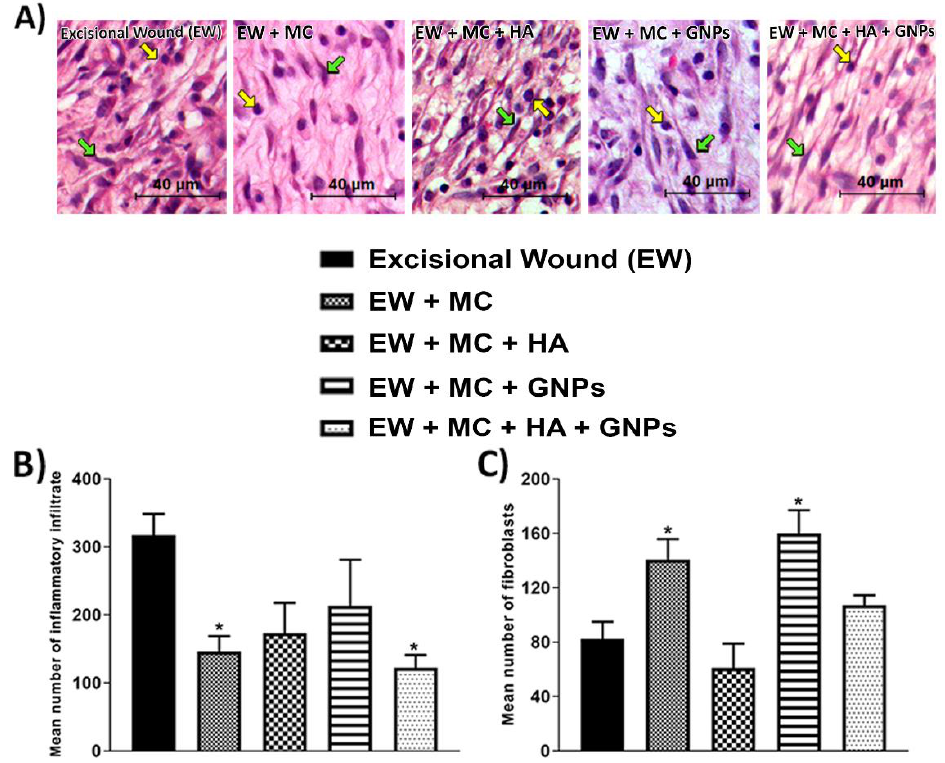
Figure 3. ( A ) Representative images of the histological sections of the integumentary system. ( B , C ) Effects of treatment with MC, GNPs, and hyaluronic acid on the number of inflammatory infiltrates ( B ) and fibroblasts ( C ). The data are presented in mean ± EPM, in which * p < 0.05 vs. excisional wound group (EW; one-way ANOVA followed by Tukey’s post hoc test).